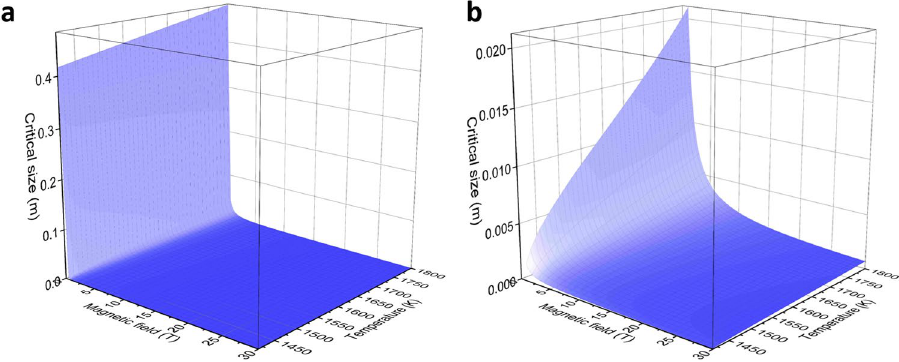
Figure 5. The critical size for instability formation of liquid Co as a function of temperature and magnetic field intensity ( a ) and ( b ) enlarged area when the field intensity is above 1 T.